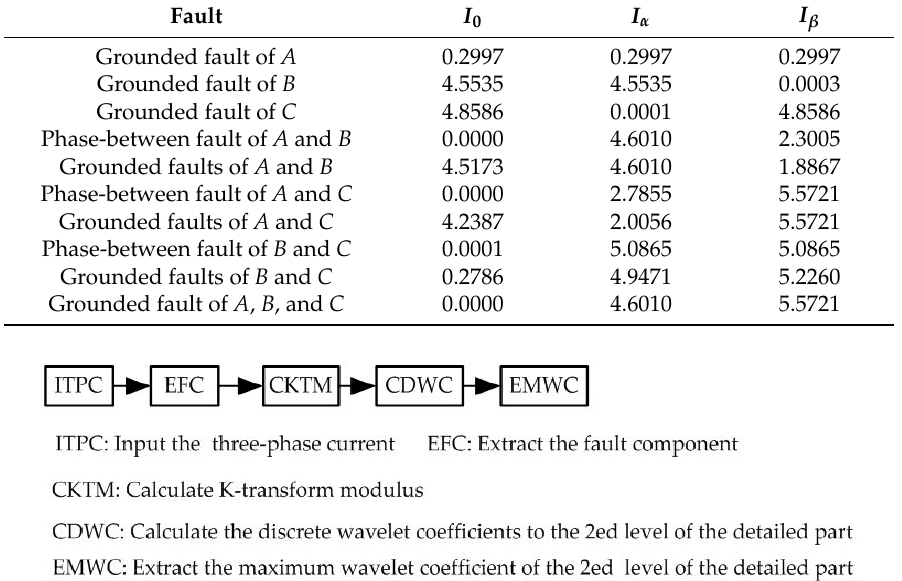
Table 4. Maximum wavelet coefficients I 0 , I α , and I β of the different faults.